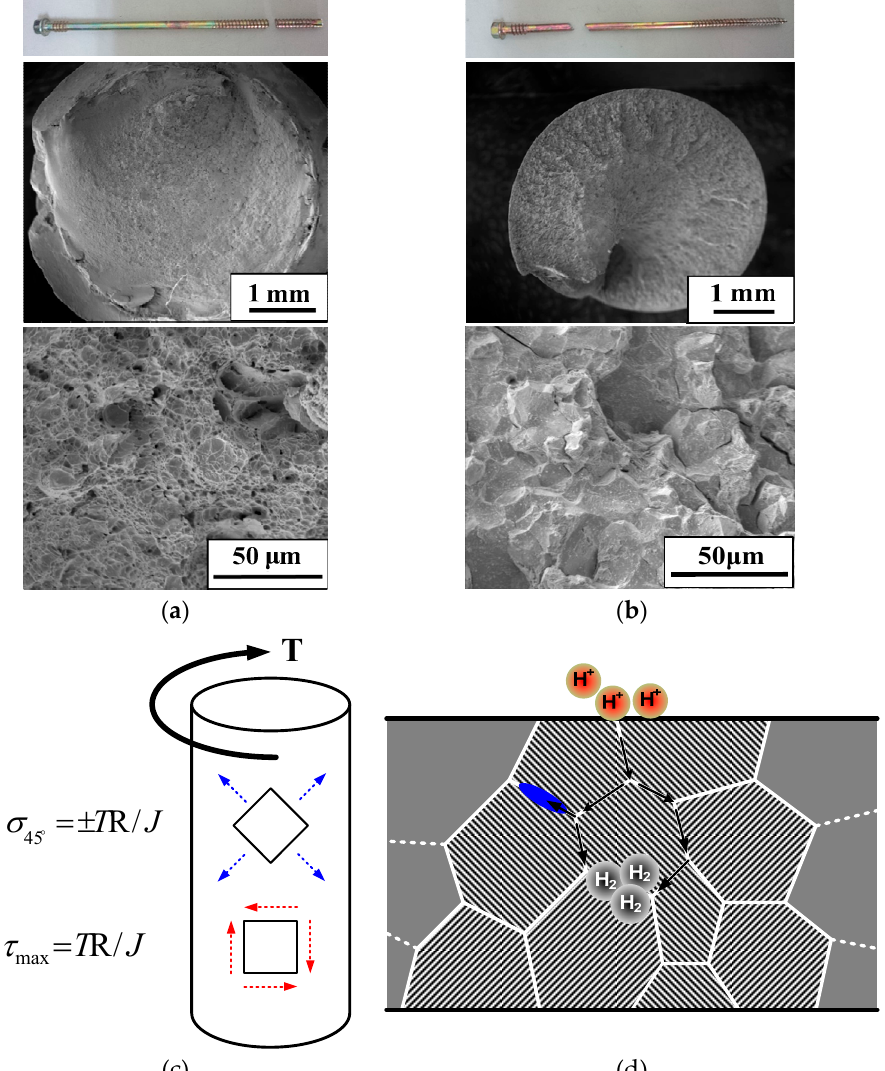
Figure 6. Macrostructure characteristics and fracture surfaces of ( a ) ductile screw and ( b ) brittle screw; ( c ) Force diagram for screw; ( d ) Diagram of HE mechanism.